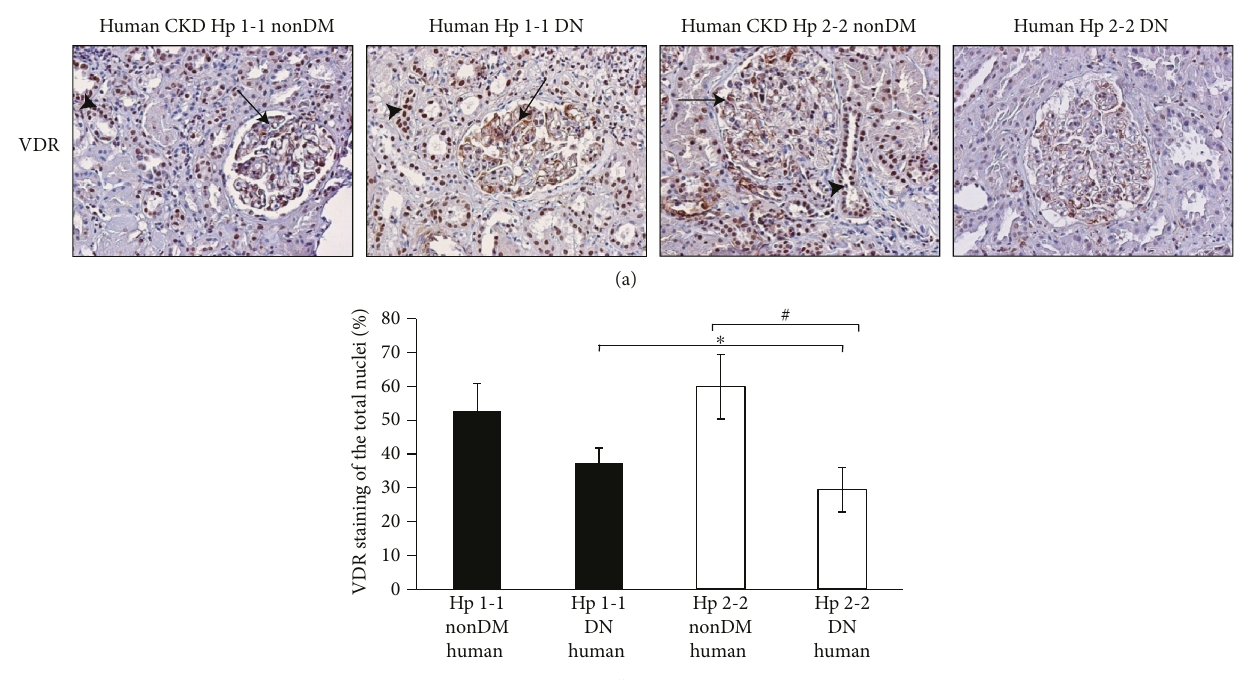
Figure 6: Renal vitamin D receptor (VDR) expression in nondiabetic (nonDM) and diabetic (DN) patients. (a) Renal biopsies from Hp 1-1 and 2-2 CKD patients were subjected to IHC of VDR. There was a signi fi cant decrease in VDR expression (brown) in the tubules (indicated by arrowheads) and in the glomerulus (indicated by black arrows) of Hp 2-2 DM renal sections compared with Hp 1-1 DM or with nonDM Hp 2-2 renal sections. (b) Quanti fi cation of VDR staining shows a signi fi cant decrease in the percentage of stained nuclei of Hp 2-2 DM sections compared with DM Hp 1-1 sections ( ∗ p < 0 001 ) or compared with the nonDM Hp 2-2 genotype ( # p < 0 001